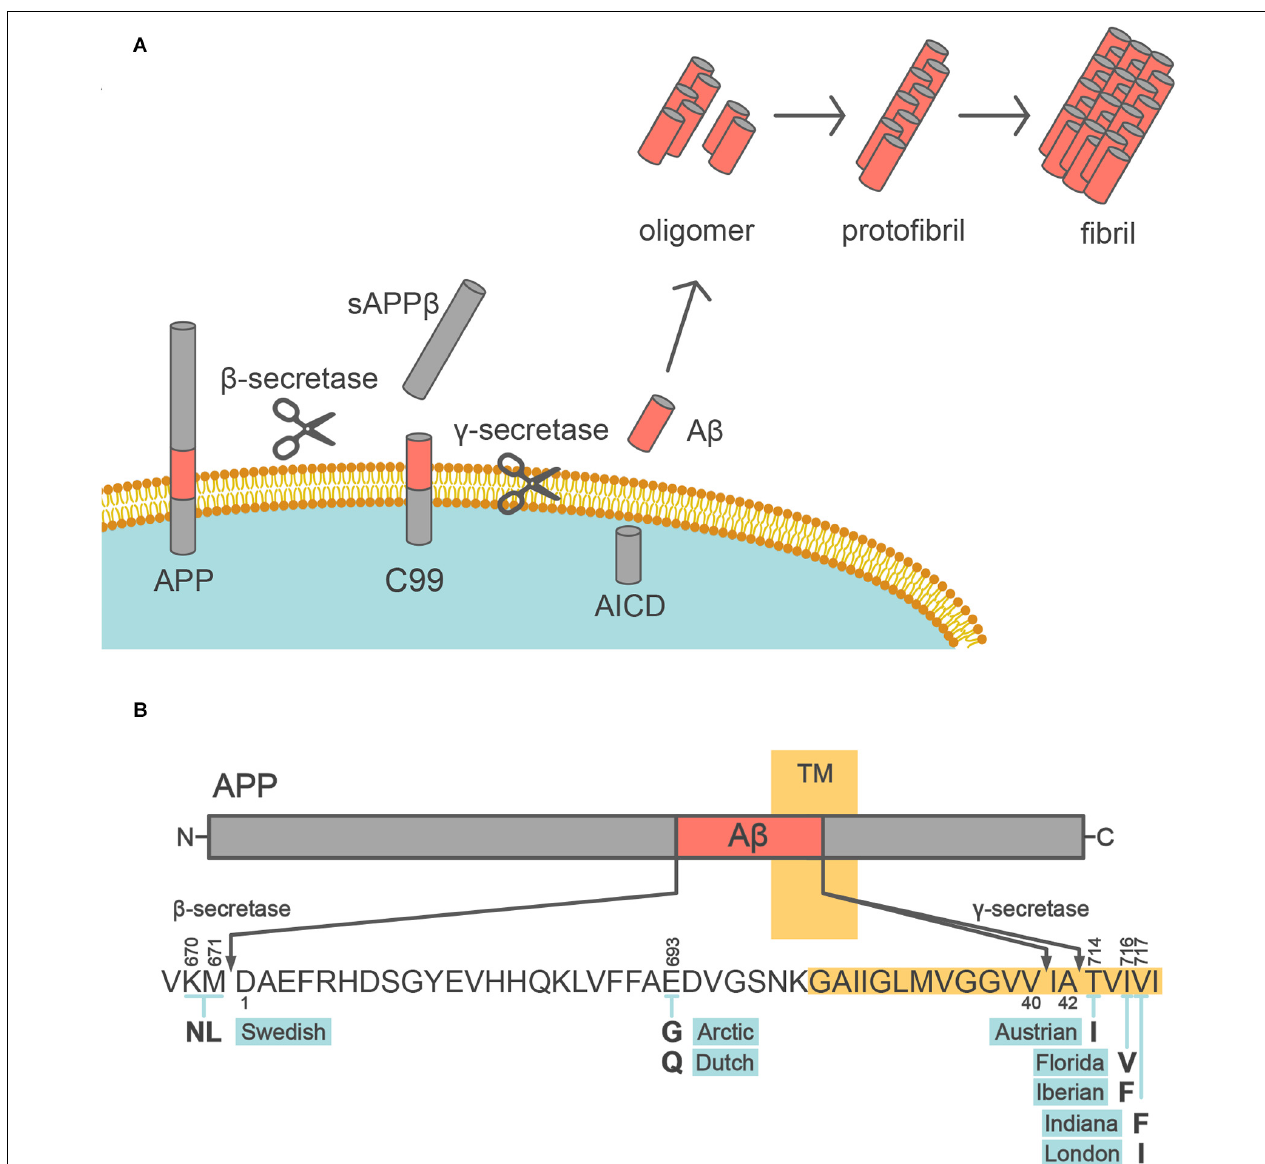
FIGURE 1 | A β production from APP. (A) Schematic depiction of the A β production pathway. APP is sequentially cleaved by β - and γ -secretases to release A β into the extracellular space. A β monomer is prone to aggregate, forming oligomers, protofibrils, and fibrils. (B) Diagram of the APP (above) and sequence of A β (below). The transmembrane segment (TM) is highlighted in yellow. The bold letters below the A β sequence indicate the missense FAD mutations within the A β sequence. The above and below the number of the A β sequence follow the numbering of the longest isoform of APP and A β amino acid sequence,